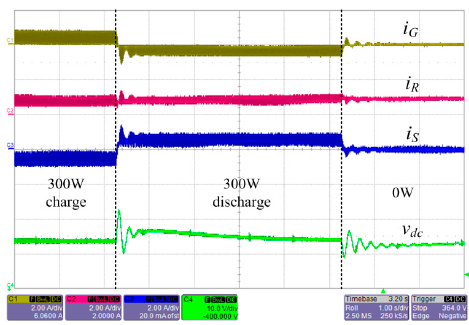
Figure 13. Experimental waveforms of EMS dispatch on State 121.